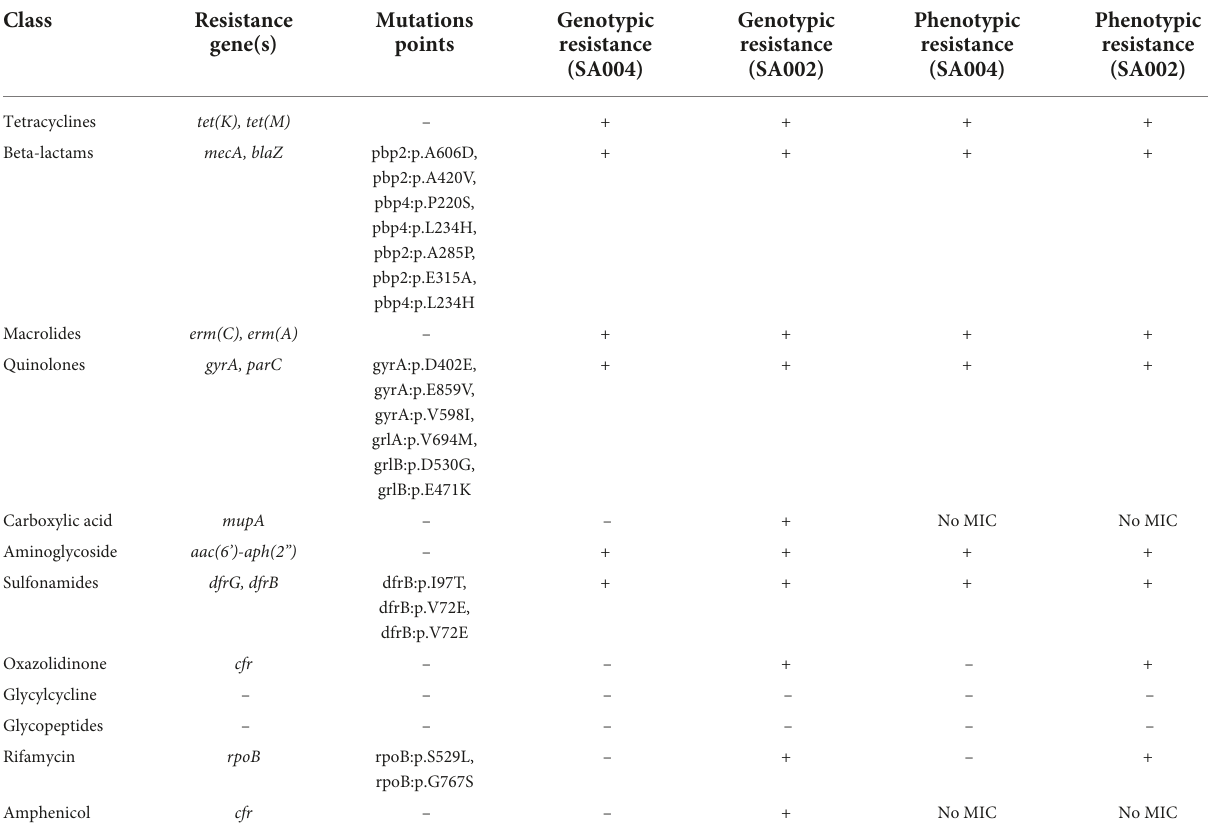
TABLE 2 Resistance genes and mutation points detected within SA002 and